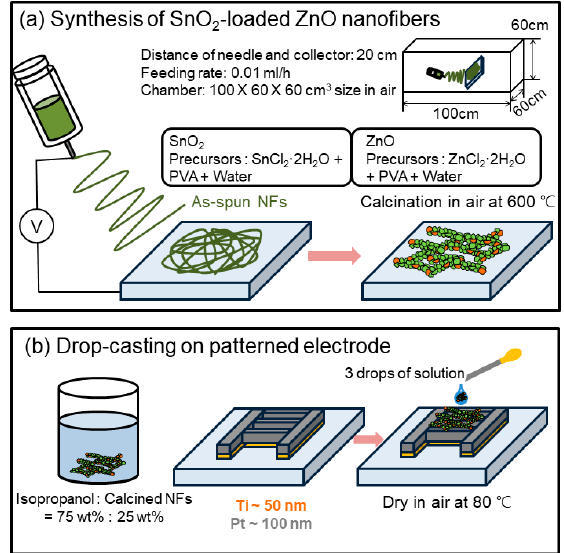
Figure 1. Illustrations of ( a ) the electrospinning method for the preparation of xSnO 2 -loaded (x = 0.05, 0.1 and 0.15) ZnO nanofibers (NFs) and ( b ) drop casting of NFs onto the patterned electrode of the sensing substrate.